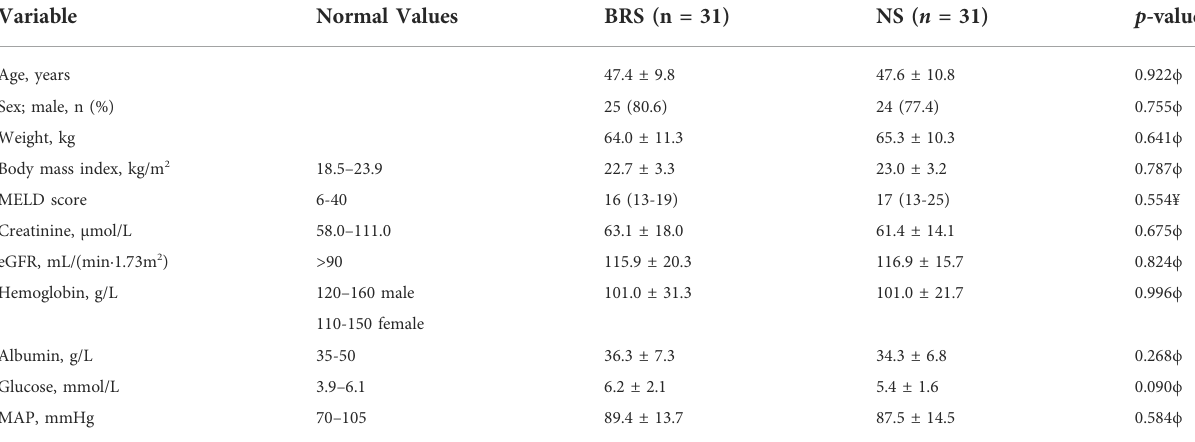
TABLE 1 Baseline characteristics of the